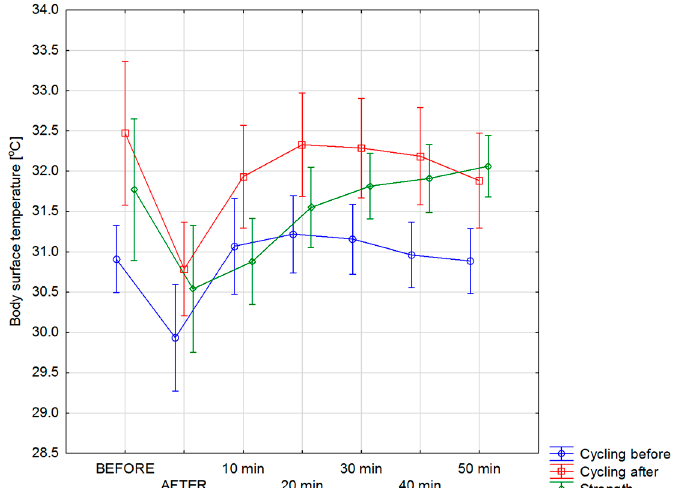
Figure 3. Mean body surface temperature changes obtained for studied group of cycling sportspersons before and after one training year and strength of sportspersons as a reference level performed before; immediately after; and after 10, 20, 30, 40, and 50 min of training.